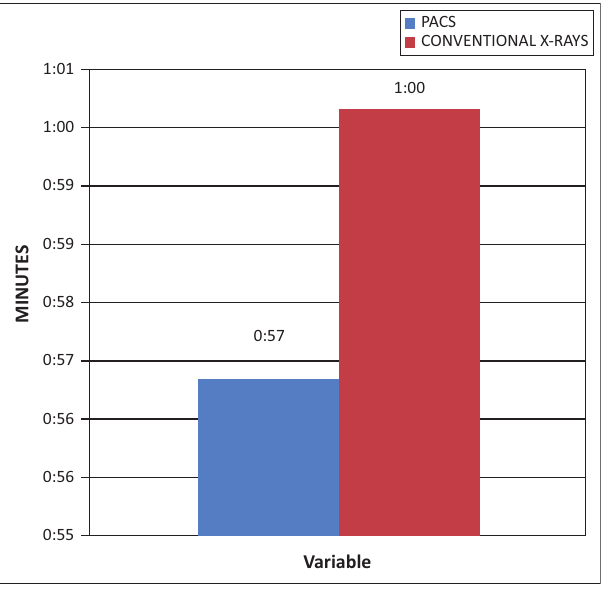
FIGURE 2: Patient waiting times in minutes for CT brain scans at Hospital A (PACS) ( N = 21) and Hospital B (conventional) ( N = 20).